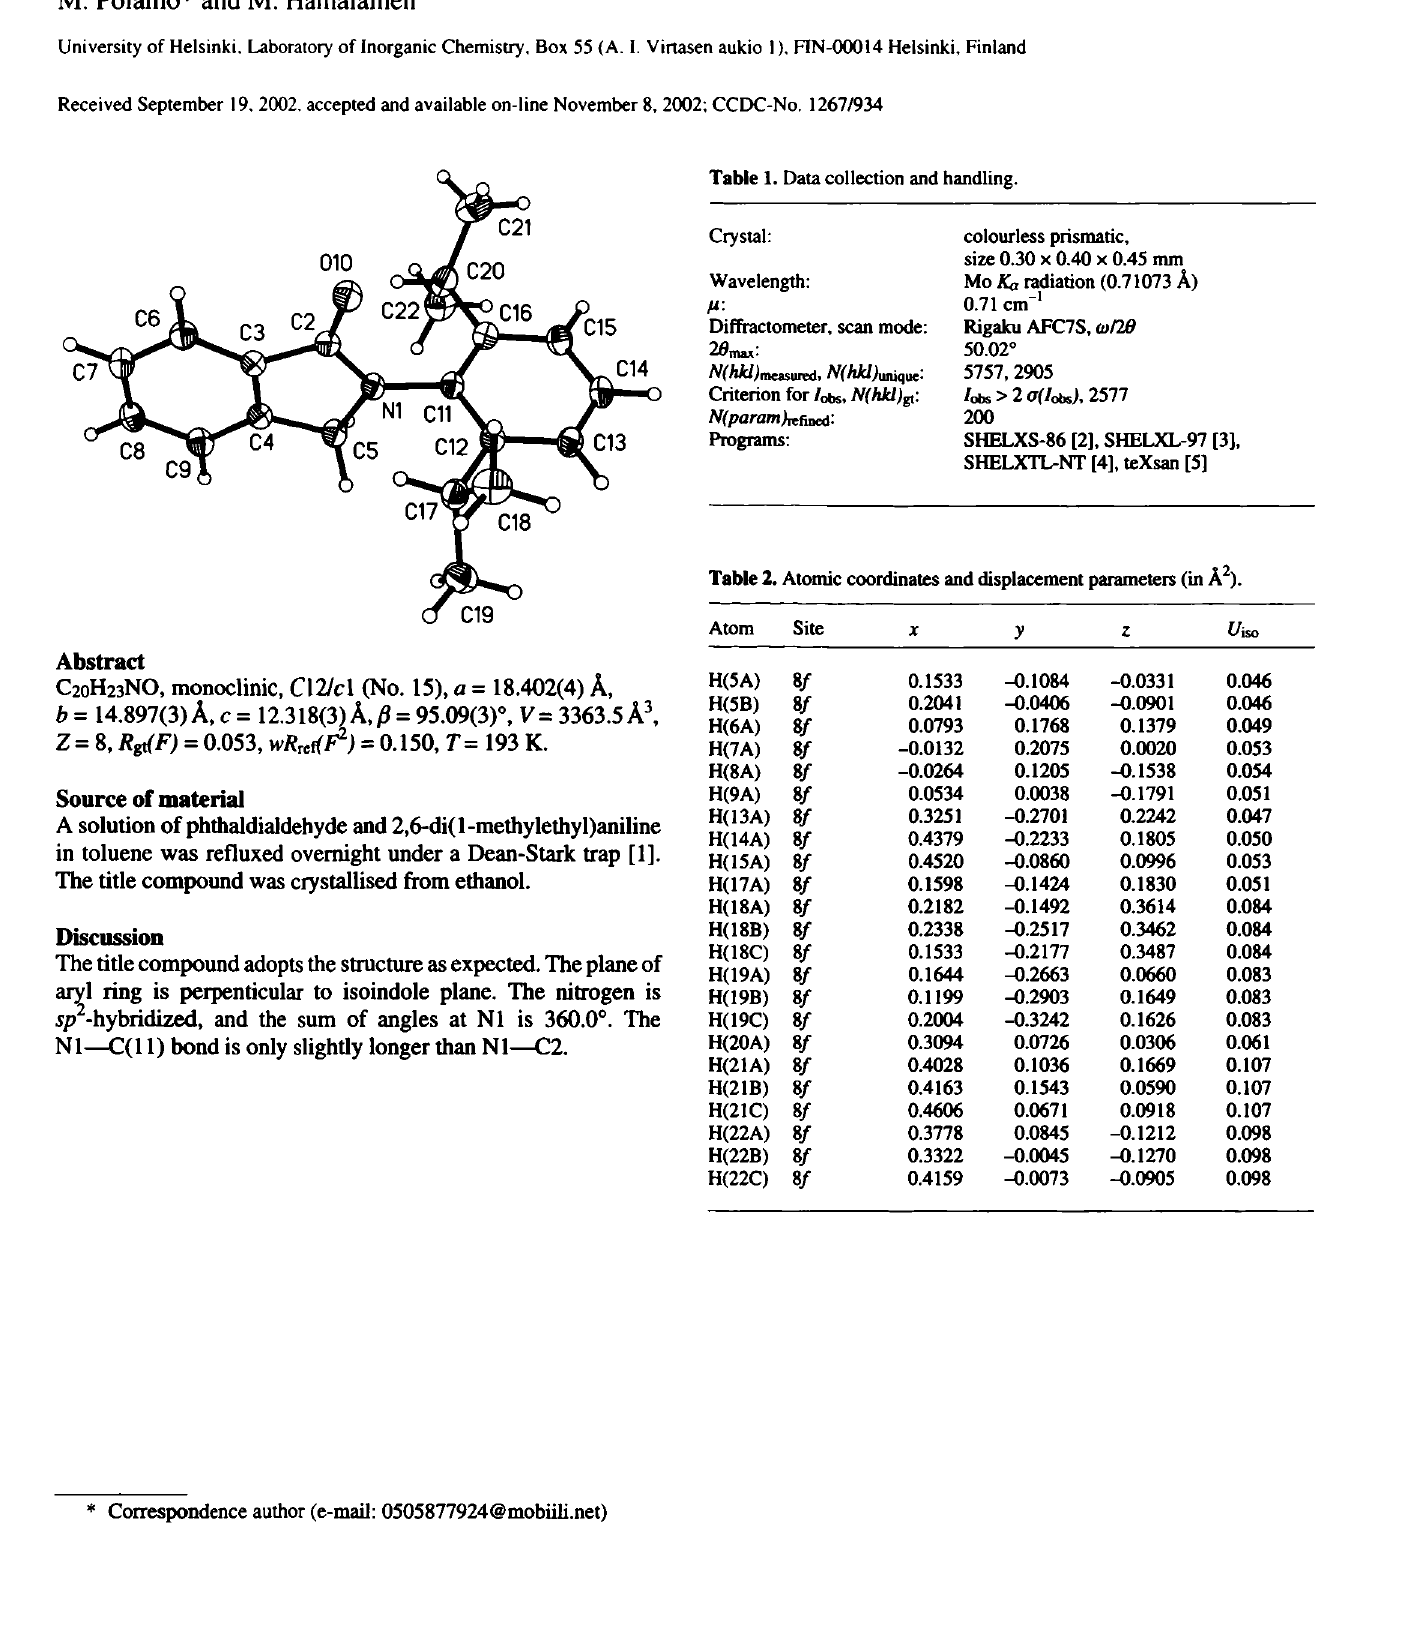
Table 2. Atomic coordinates and displacement parameters (in Â 2